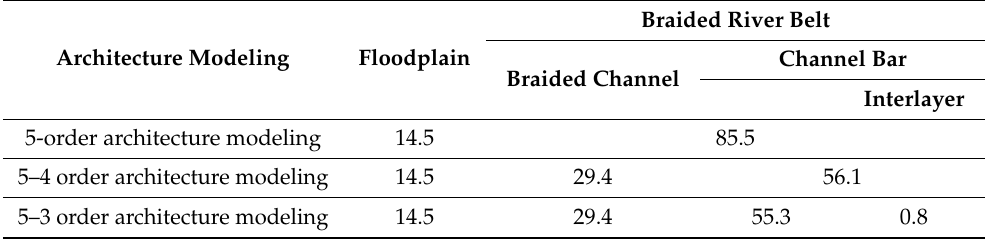
Table 2. Proportion of each architectural element in different hierarchies of the model.